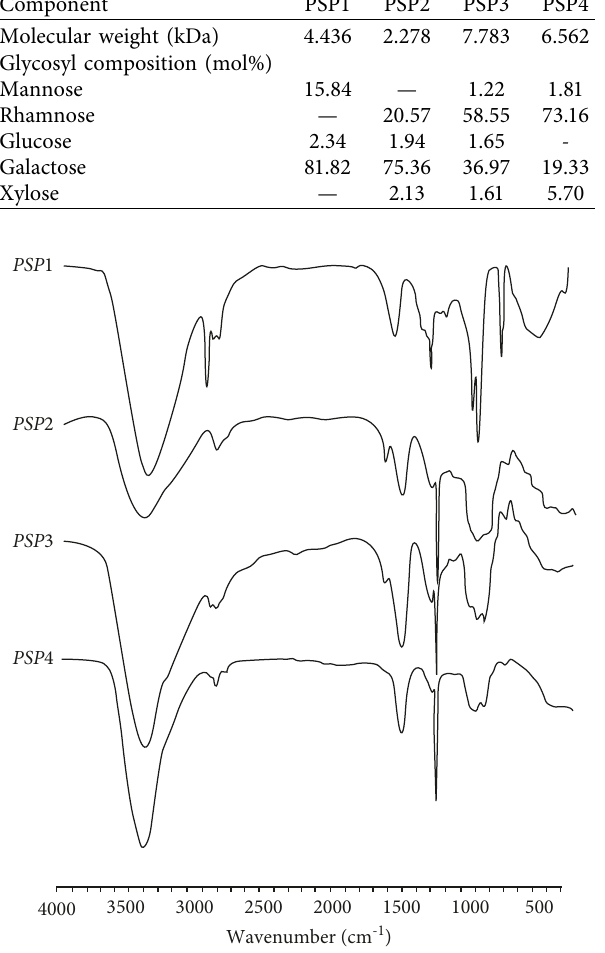
Figure 2: FI-IR analysis of PSPs components.